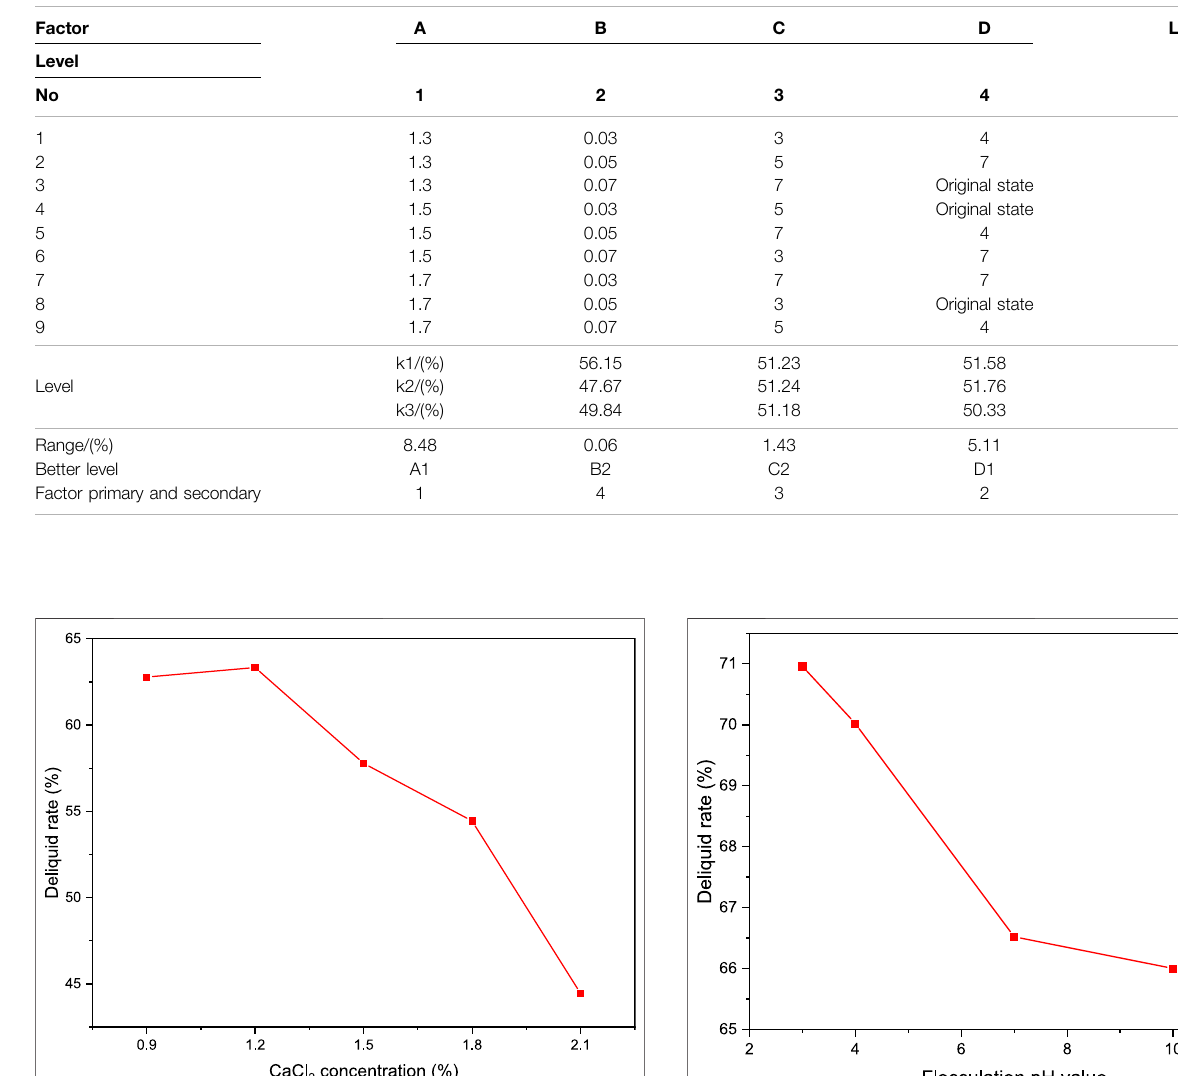
TABLE 4 | Analysis table of test results.